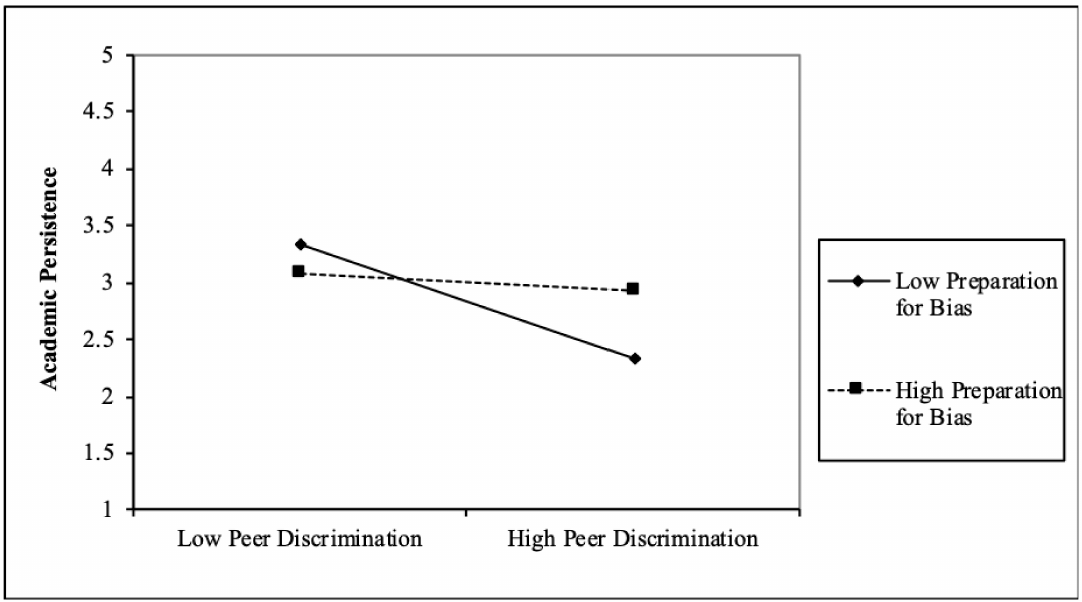
Figure 1. Academic Persistence–Moderation: Preparation for